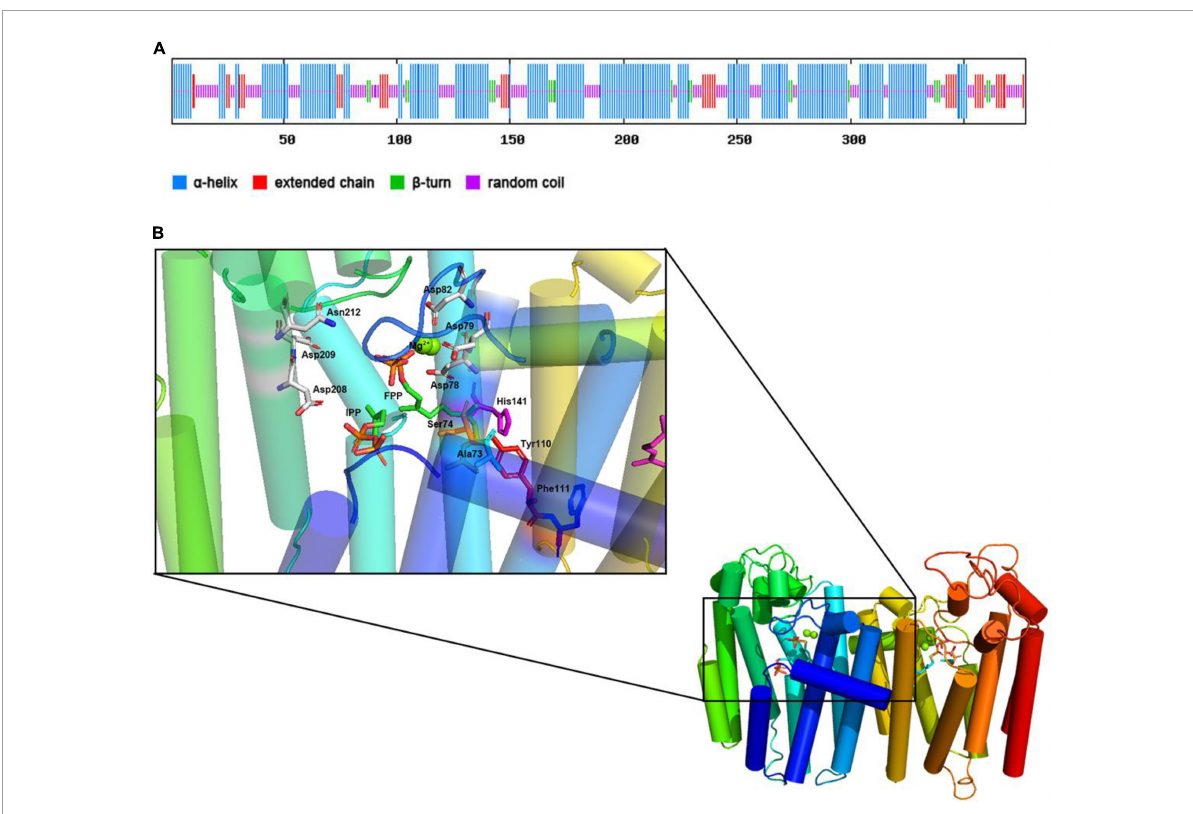
FIGURE3 Predicting secondary structure and 3D-model of CrtE. (A) Prediction of secondary structure of CrtE. (B) 3D-model of the CrtE. The 3D-model prediction of CrtE was performed with the online software SWISS-MODEL. The resulting CrtE 3D-model was visualized in Pymol (The PyMOL Molecular Graphics System, Version 2.0 Schrödinger, LLC.), compared with the Saccharomyces cerevisiae GGPPS (PDB ID code 2E8T) model, and ligands FPP (PDB ID code 2E90) and IPP (PDB ID code 2E8U) were